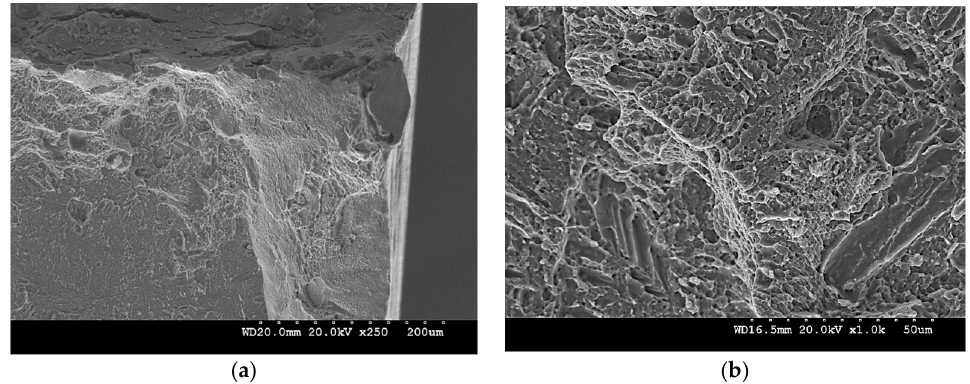
Figure 11. Fractograghs of vacuum brazed specimens showing ( a ) the initial fracture position and ( b ) the ductile fracture dominated by dimples.